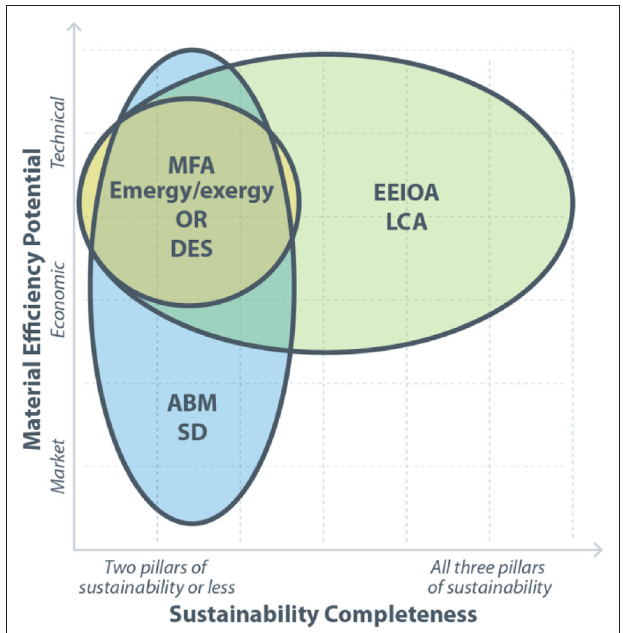
FIGURE 3 | Capacity of reviewed methods to capture material efficiency potentials and sustainability completeness. Industrial ecology methods are limited to the techno-economic potential, while complex systems science methods allow studying the three material efficiency potentials (see ordinate). The directions of the figure’s axis do not denote superiority but rather a logical order (e.g., the technical potential may be modeled before the economic and market potential). ABM, agent-based modeling; SD, system dynamics; MFA, material flow analysis; EEIOA, environmentally extended input-output analysis;